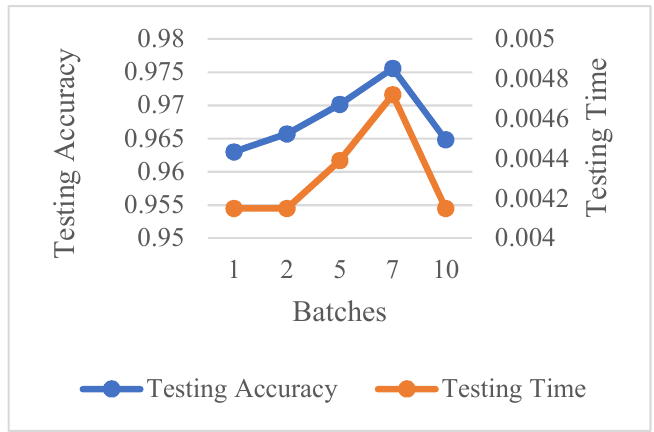
Figure 5. Accuracy and computation time at different hidden layer sizes.